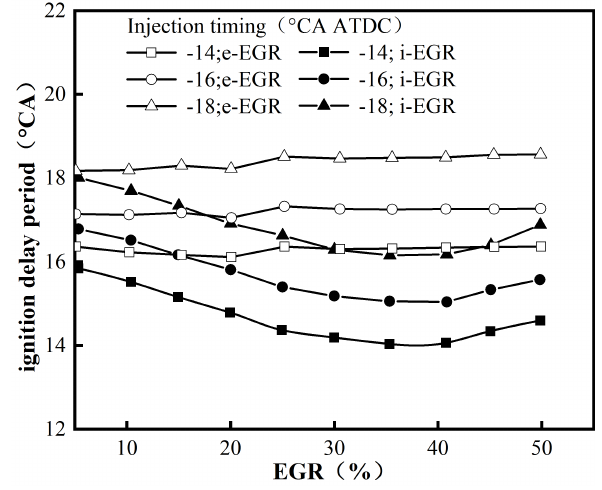
Fig. 4 Effects of i-EGR and e-EGR ratios on ignition delay period.